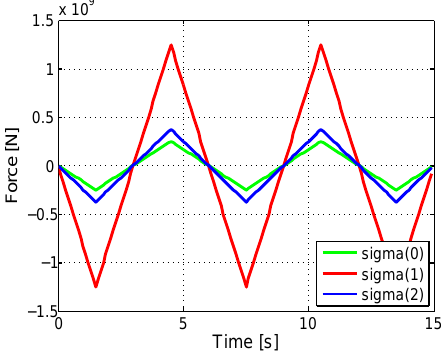
Figure 3. Decomposed applied force at point E according to time.